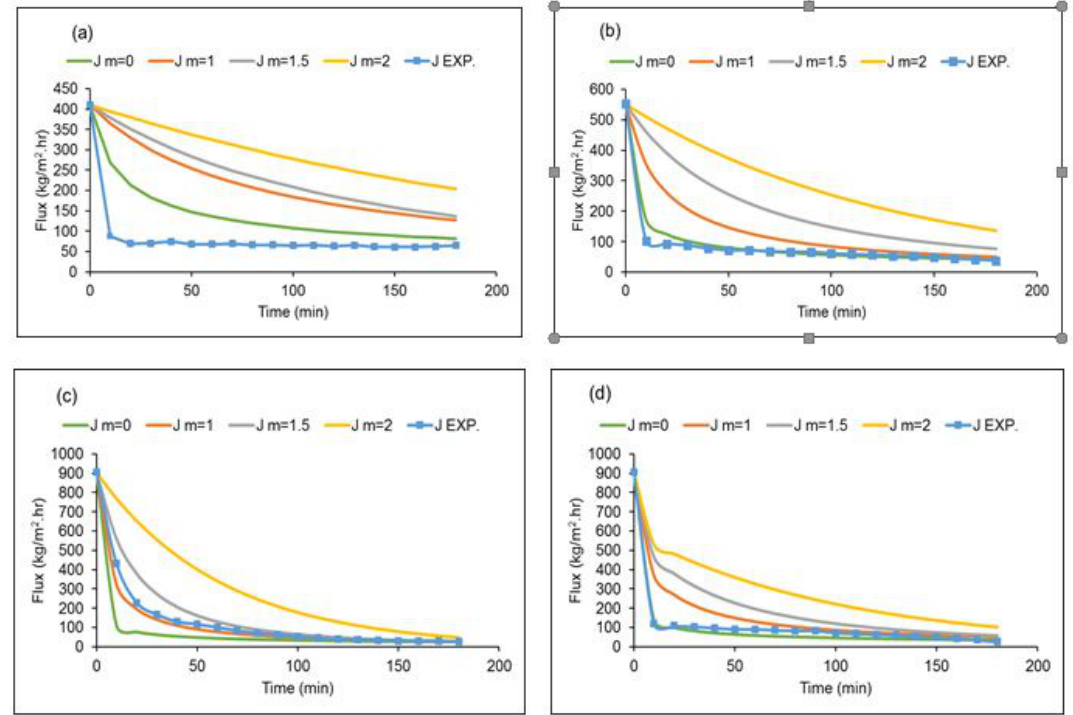
Fig. 7. Experimental data and Hermia fouling models for (a) PSf, (b) PSf/SND (0.5 wt%), (c) PSf/SND (1.0 wt%), (d) PSf/SND (1.5 wt%) membrane during filtration of HA solution.